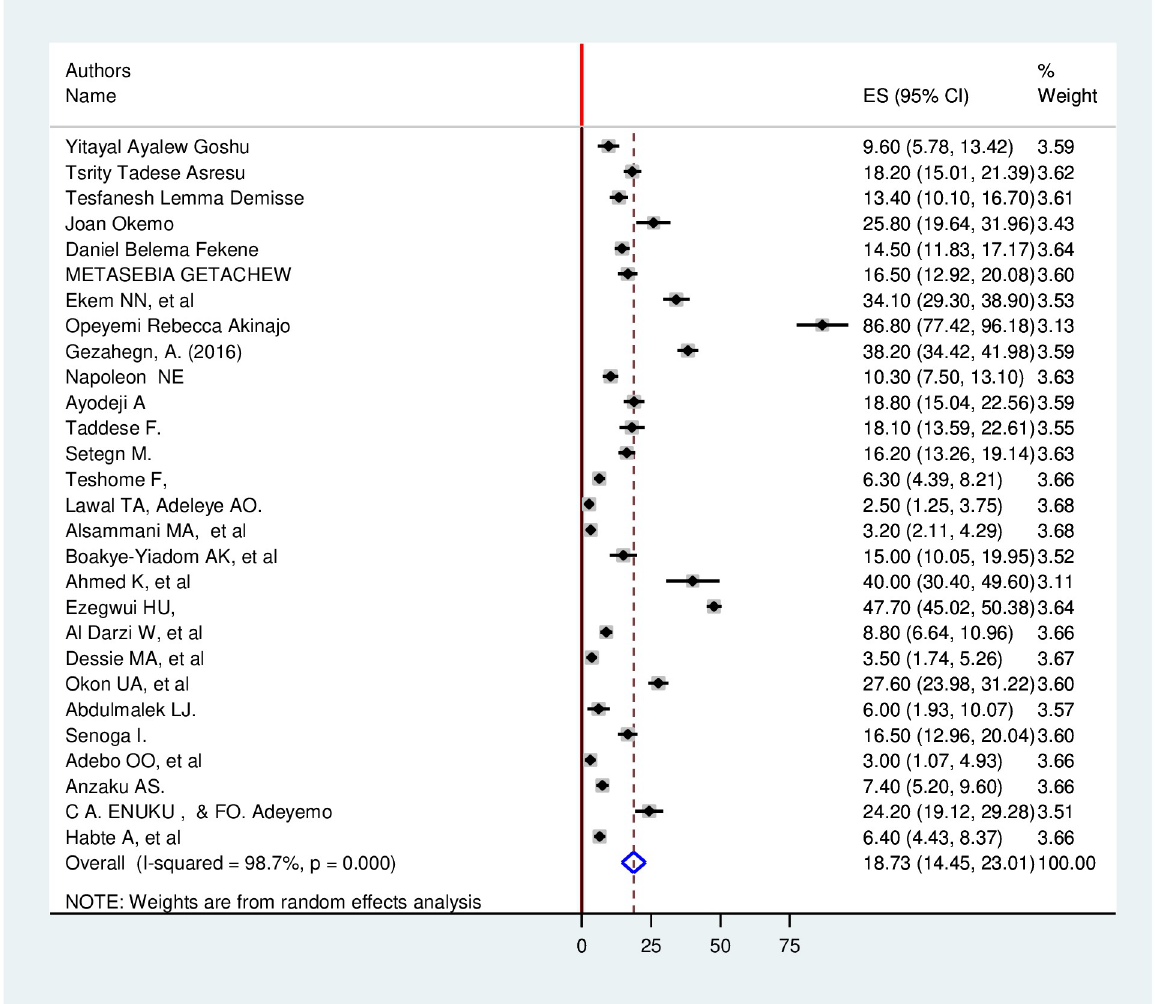
Fig 2. Forest plot showing pooled prevalence of utilization of preconception care among women in Africa.